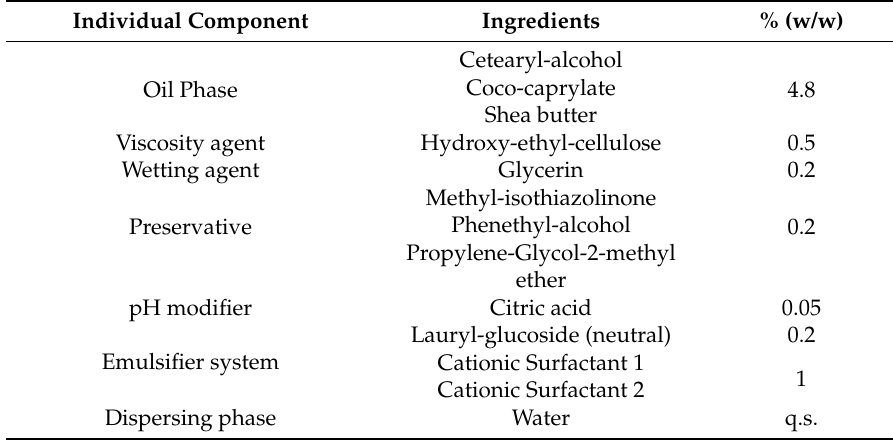
Table 1. Hair conditioner product prototype